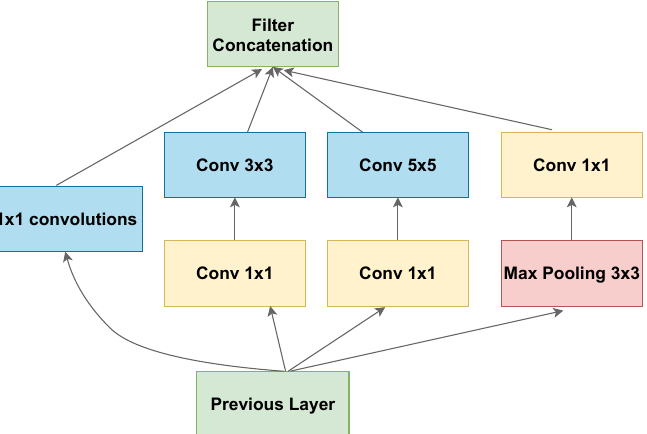
Figure 4. A schematic diagram representing an inception block. (Chollet